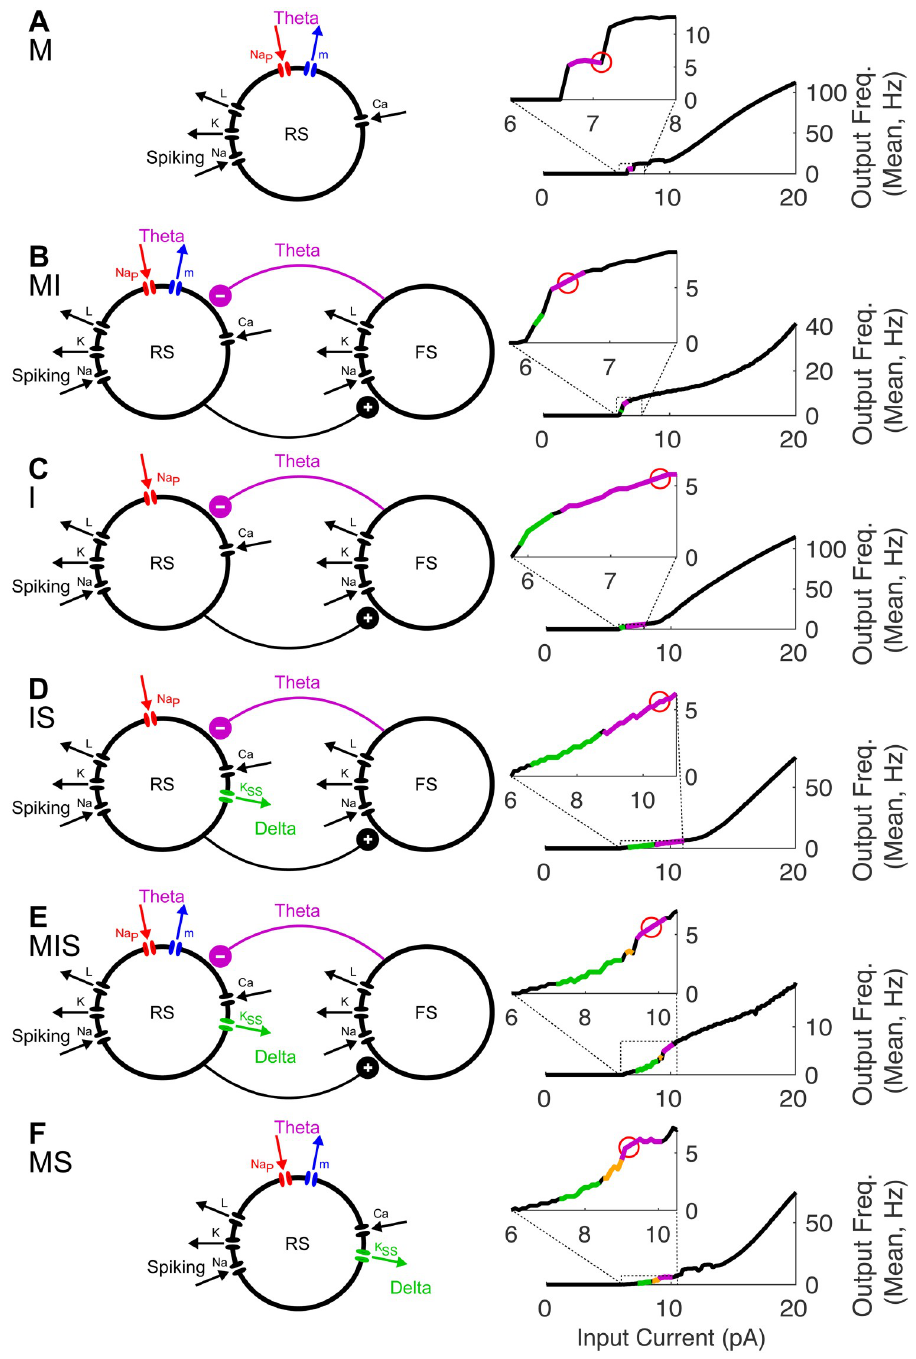
Fig 1. Model θ oscillators. For each model (A-F), schematics (left) show the currents present, color-coded according to the timescale of inhibition ( δ in green, θ in purple). FI curves (right) show the transition of spiking rhythmicity through δ and θ frequencies as I app increases ( δ in green, θ in purple, and MMOs in gold); the red circle indicates the point on the FI curve at which I app was fixed, to give a 7 Hz firing rate.